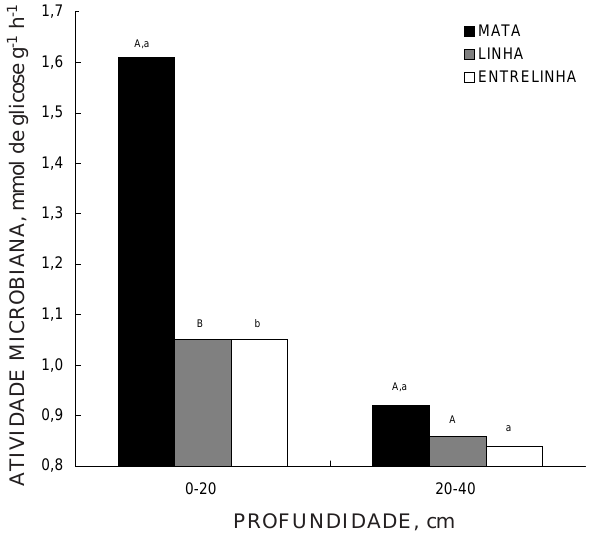
solo.Figura 7. Valores médios de atividade microbiana, nas profundidades de 0-20 e 20-40 cm, para